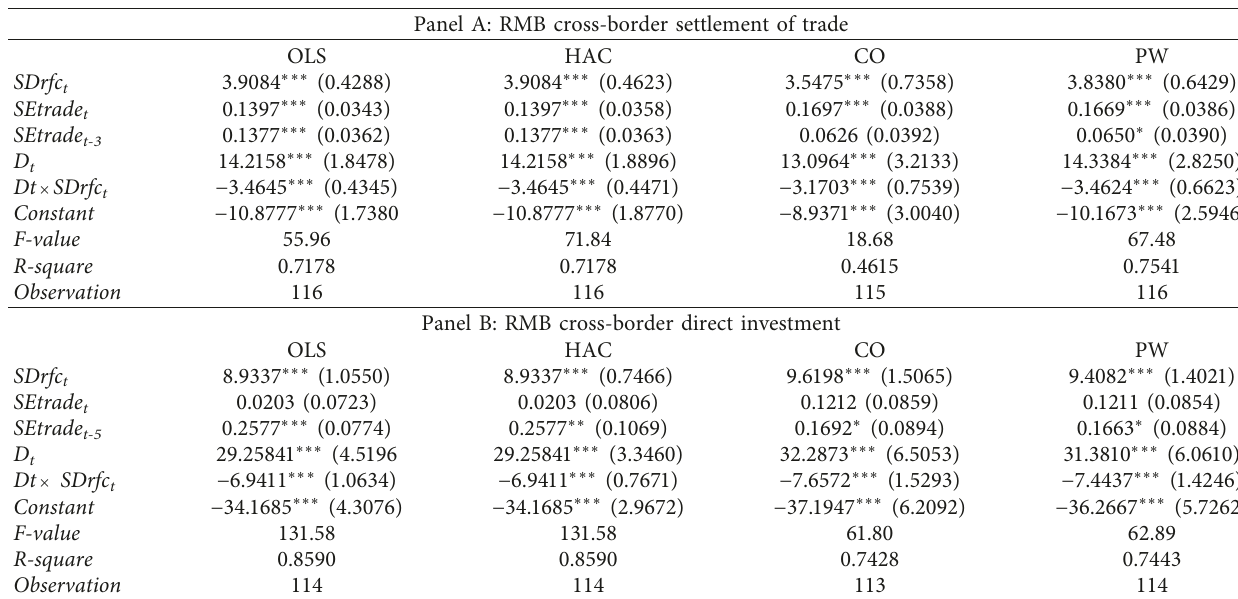
Figure 1: Time-series line of data sample. Table 2: Summary of